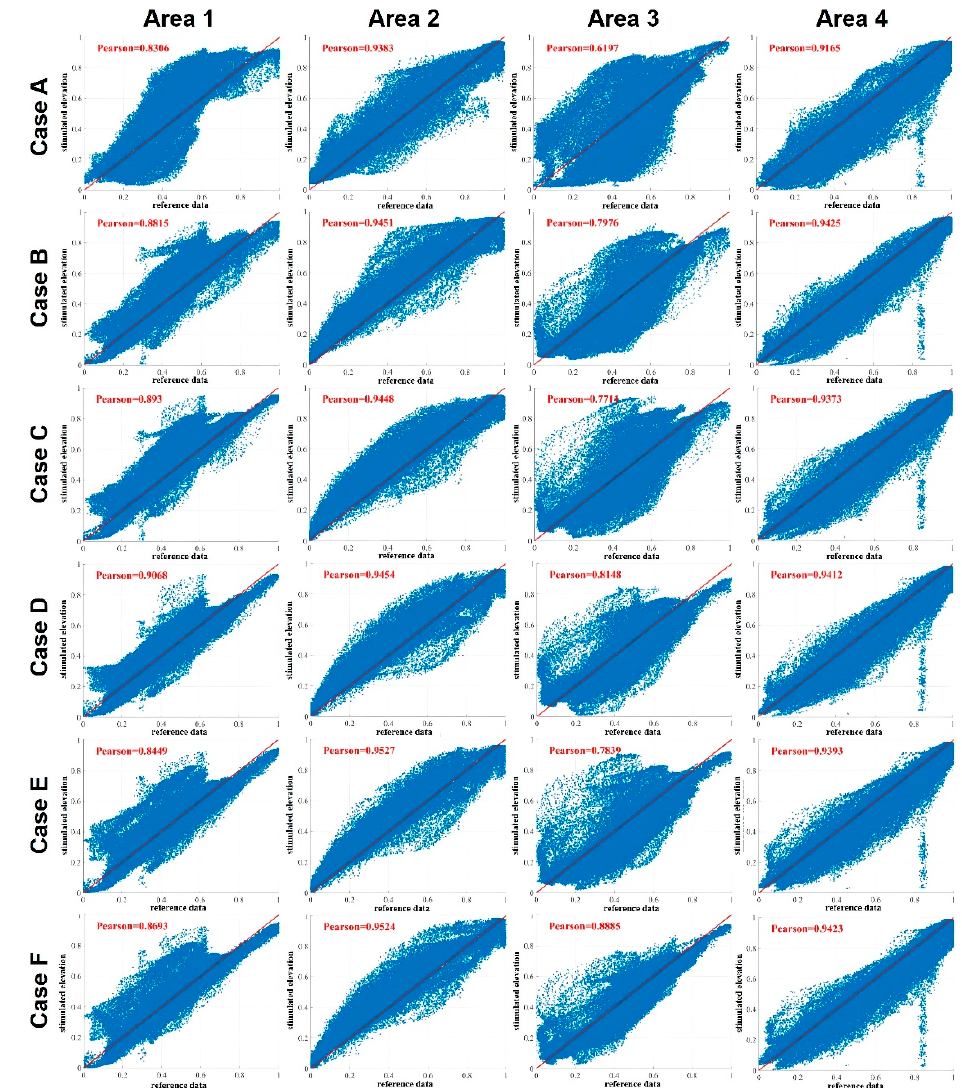
Figure 6. Results based on the different combinations of topographic features. Ref DEM represents the reference data.